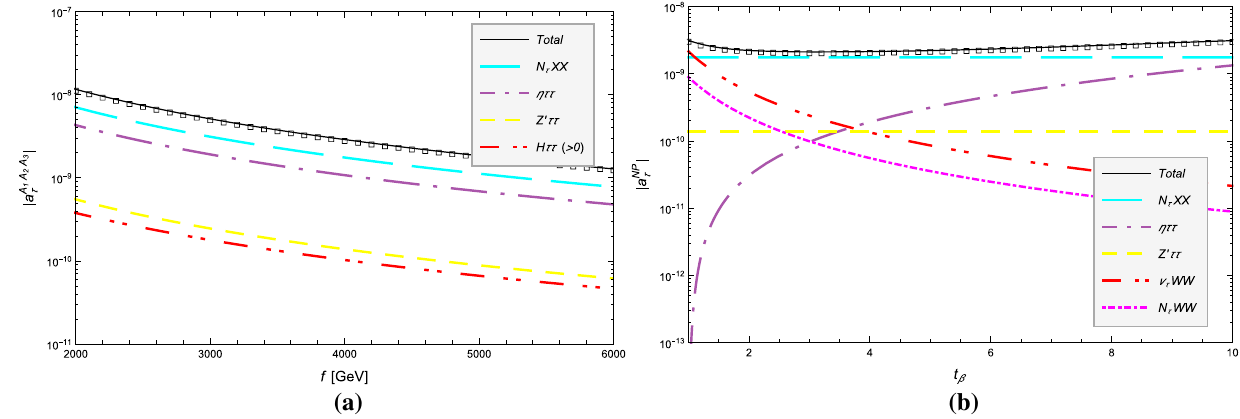
below the 10 − 10 level are not shown. The three-letter tags denote the virtual particles circulating in each type of Feynman diagram. All the contributions are negative except the H ττ one. The absolute value of the sum all of the contributions is also shown ( solid lines with squares